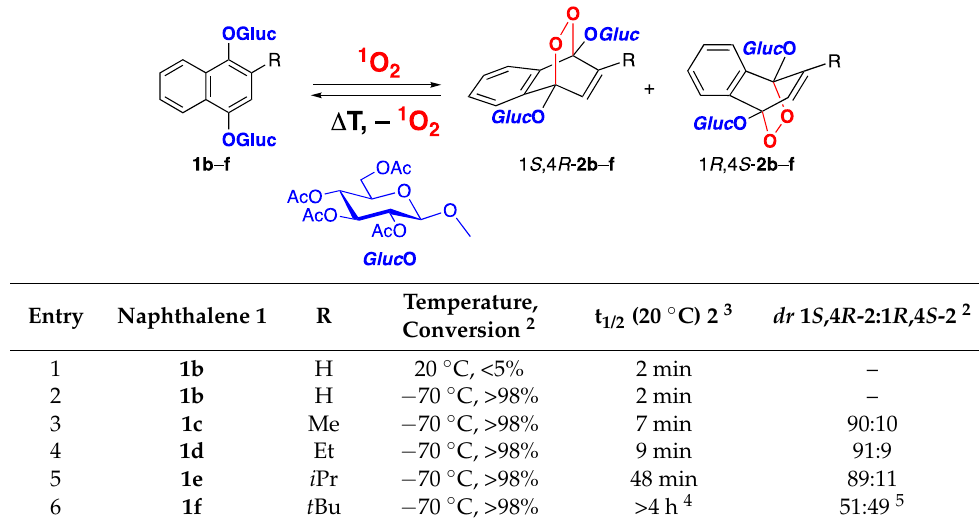
Table 1. Photooxygenation of naphthalenes 1b – f to endoperoxides 2b – f 1 .